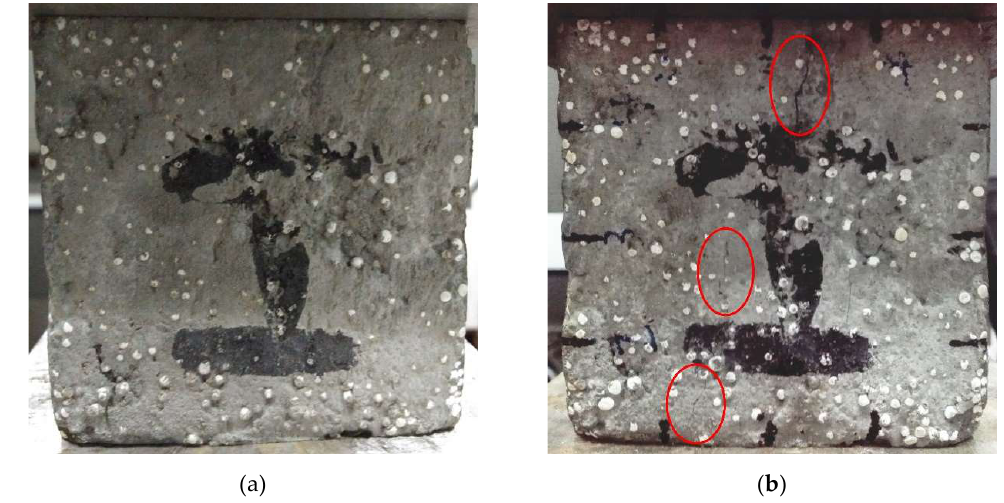
Figure 5. The face of structural EPS concrete before and after micro-cracks appeared: ( a ) 15,500,000 times; ( b ) 16,350,000